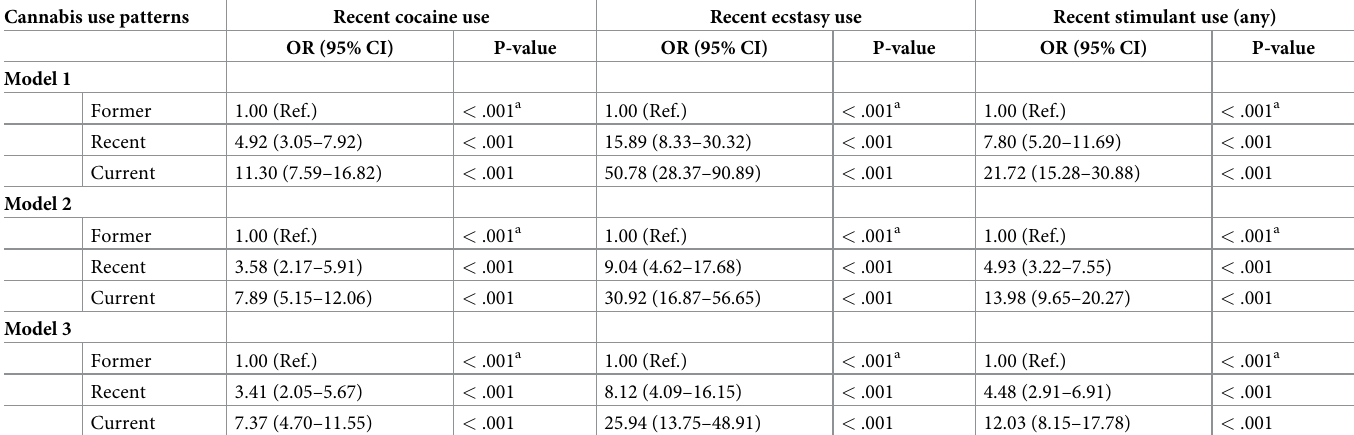
Table 2. Odds ratios for the associations between patterns of cannabis use and recent stimulant use. Cannabis use patterns